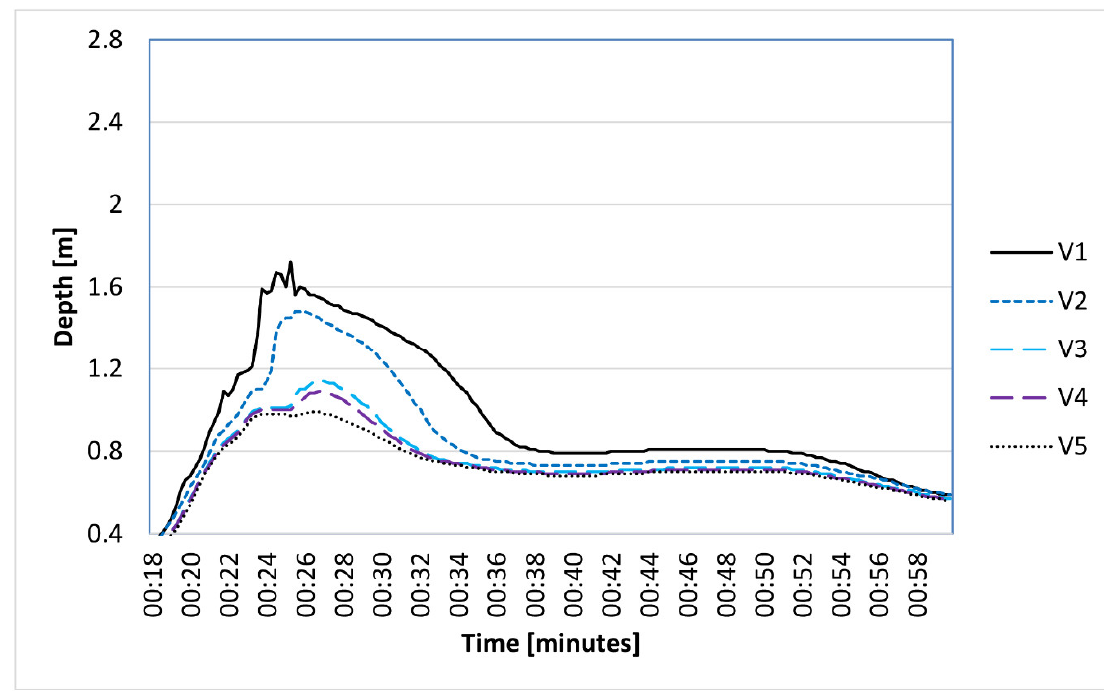
Figure 14. Depth change in Link-30 canal—F = 3 years.